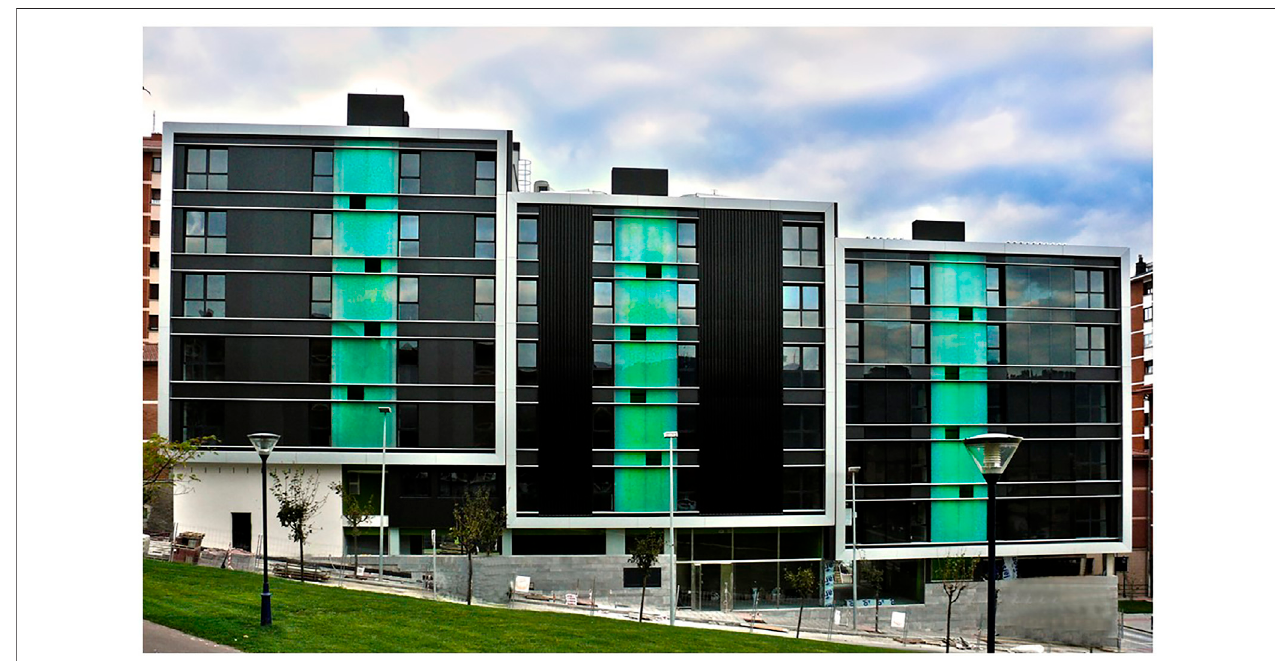
FIGURE 2 | Photograph of the three